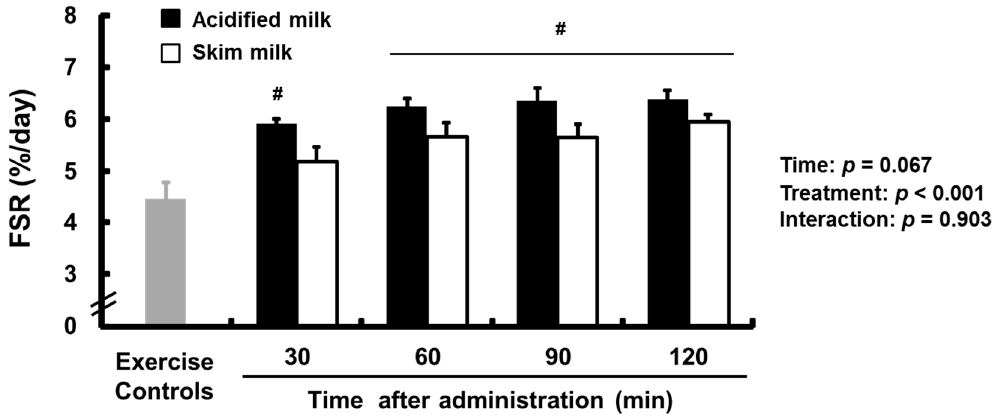
Figure 3. The FSR of triceps muscle tissue from rats administered acidified milk or skim milk. Data are presented as means ± SEM ( n = 6–8). # Significantly different from the exercise-only control group, p < 0.05. FSR, fractional synthetic rate; SEM, standard error of the mean.